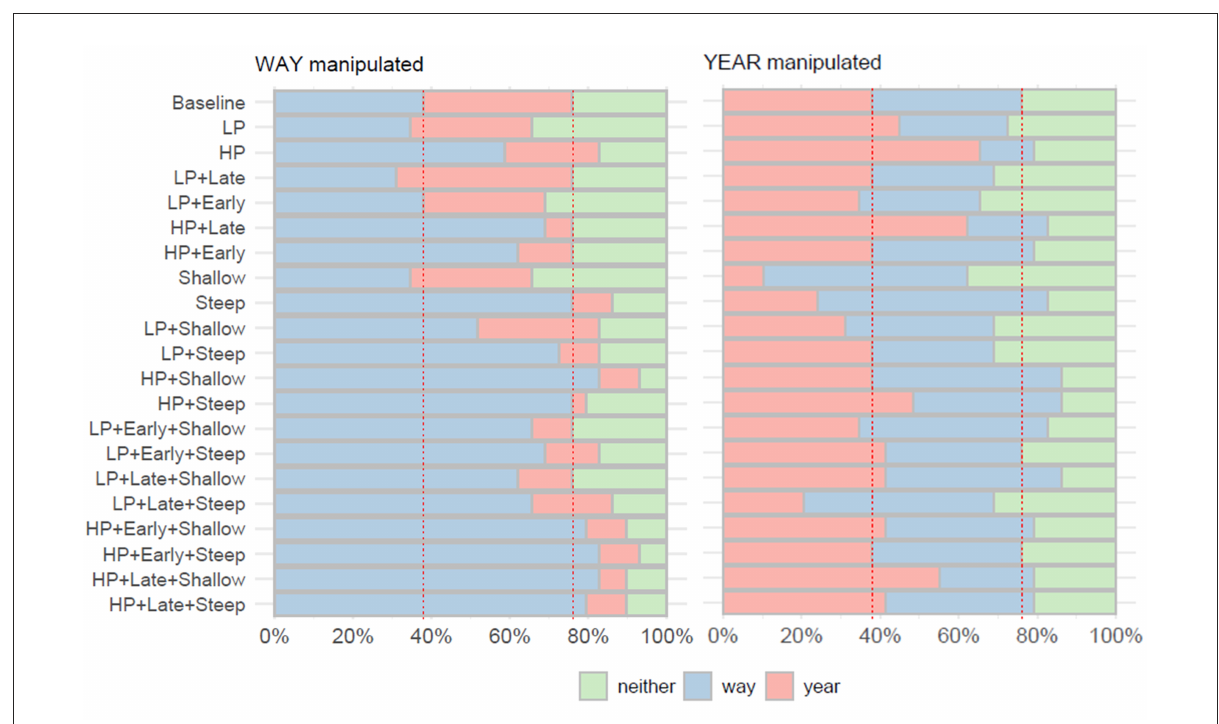
FIGURE4 Frequencies with which syllables WAY, YEAR or neither were identified as prominent in the synthetic stimuli. LP, low peak; HP, high peak; Late, late peak; Early, early peak; Steep, steep deaccentuation; Shallow, shallow deaccentuation (see also Table 1). Red dotted lines indicate results for the Baseline